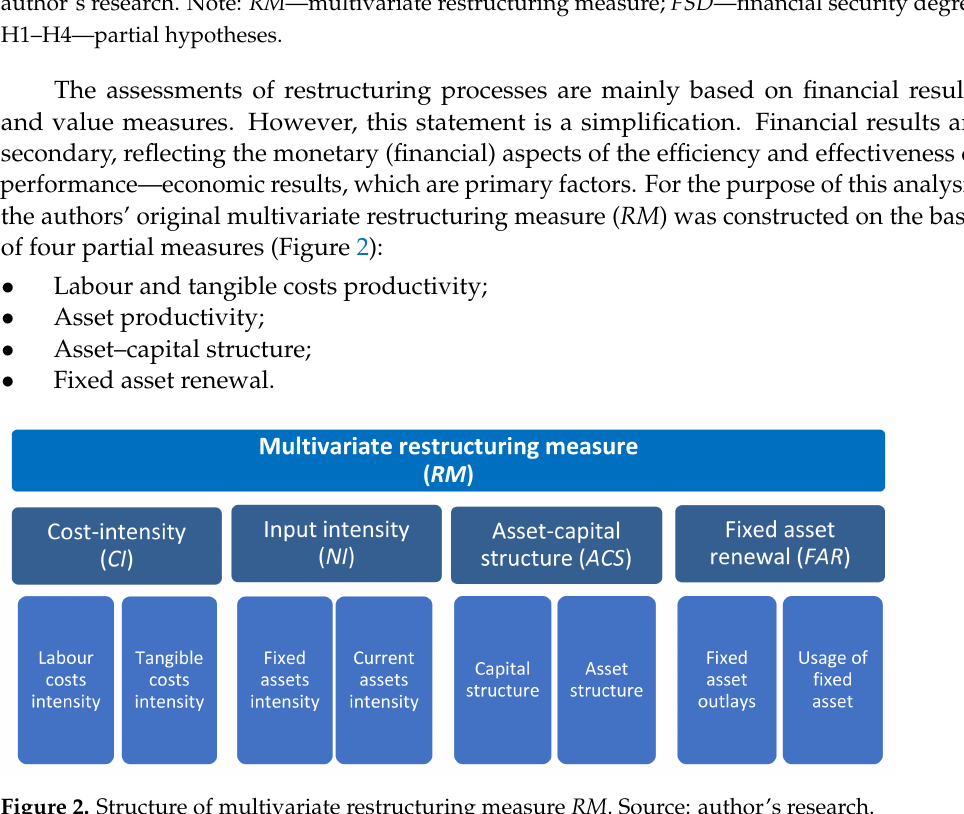
Figure 1. The research framework and process relationships in terms of partial hypotheses. Source: